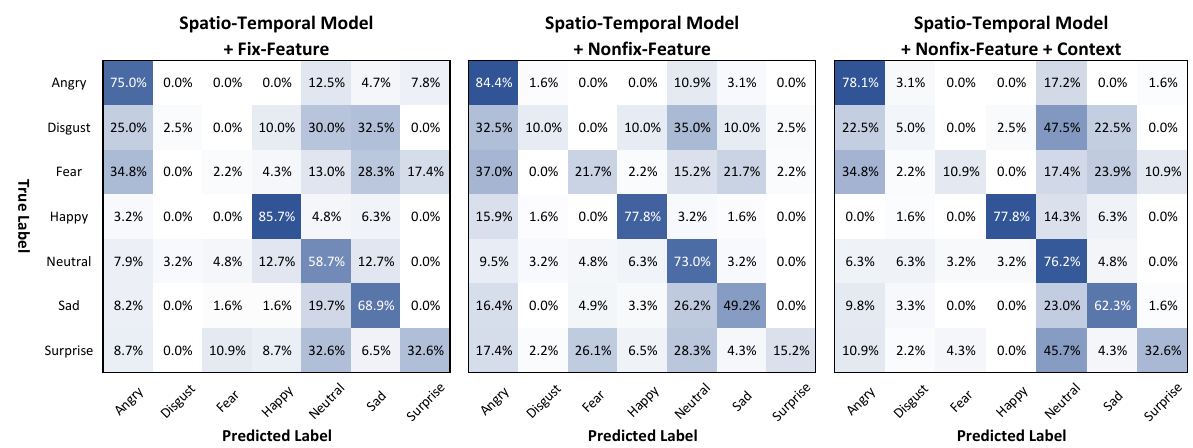
Figure 11. Confusion matrix of Models 1–3 (spatiotemporal approach) on the AFEW validation